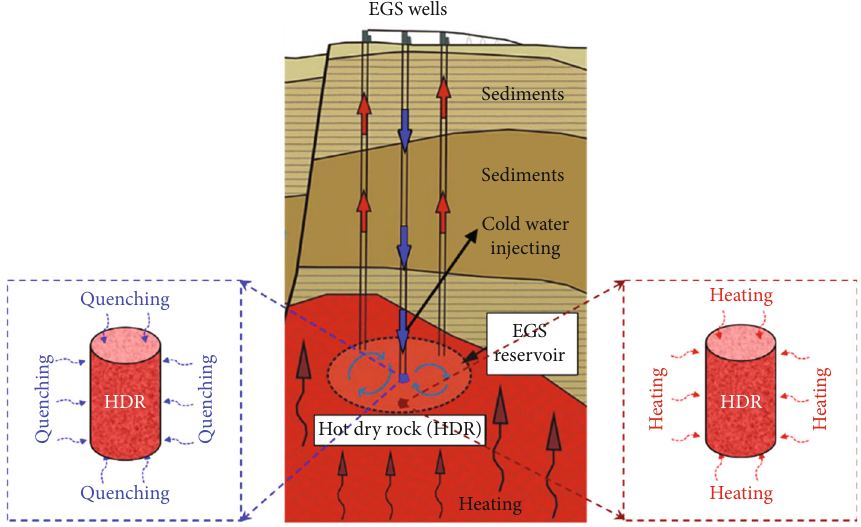
Figure 1: Heating and quenching of HDR in a typical